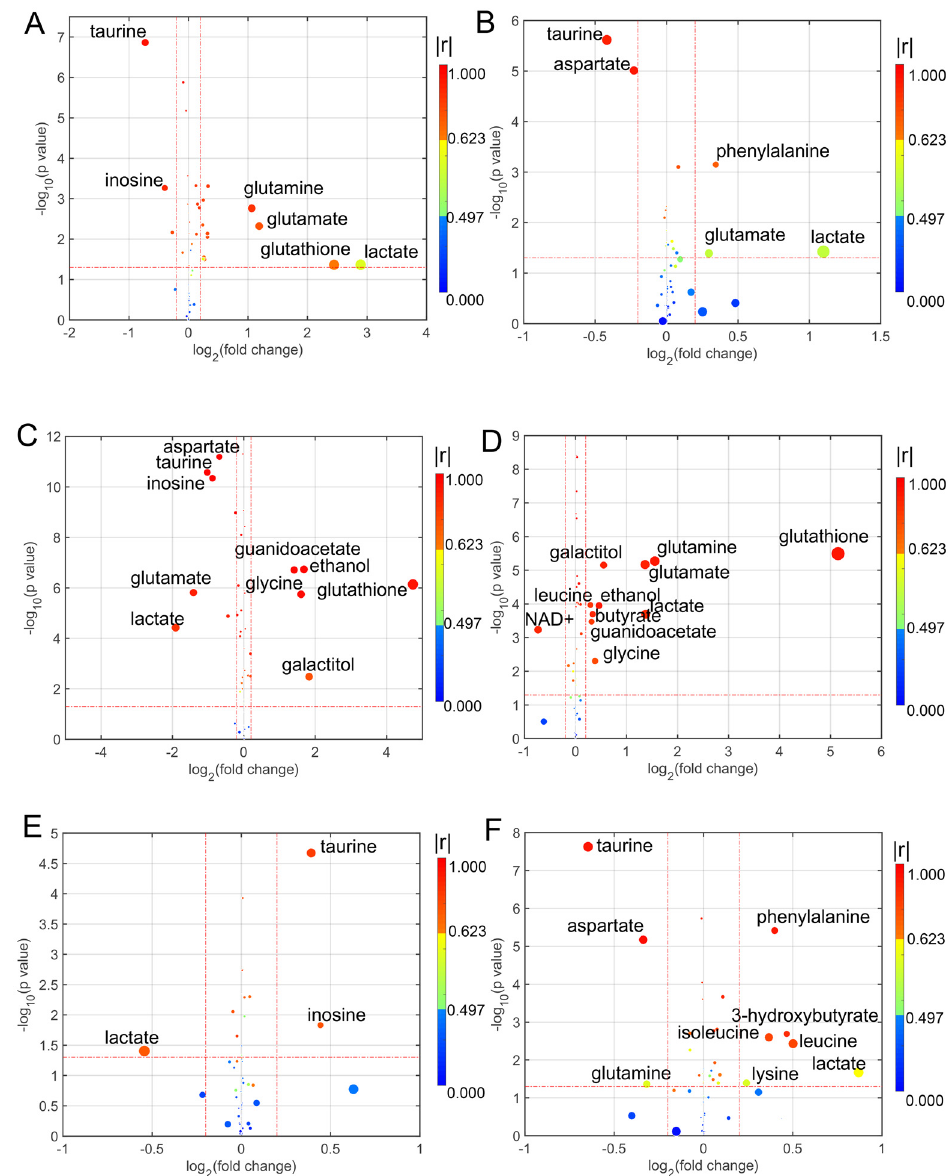
Figure 3. Enhanced volcano plots showing significantly different metabolites. ( A ) CD7 group vs. Control group; ( B ) CD8 group vs. Control group; ( C ) CD9 group vs. Control group; ( D ) CD10 group vs. Control group; ( E ) CD11 group vs. Control group; ( F ) CD12 group vs. Control group. Volcano plots show log2 (fold change) on the x-axis and − log10 ( p value) on the y-axis. Each point represents a metabolite. The circles’ size and color are determined based on the variable importance projection (VIP) and absolute correlation coefficient values (|r|), respectively. For each comparison, the larger the VIP value the larger the size of the circle, and the warmer color corresponds to higher |r|; the gradient blue means |r| is less than 0.497; the gradual bright yellow means |r| is greater than 0.497 and is less than 0.623; the gradient red means |r| is greater than